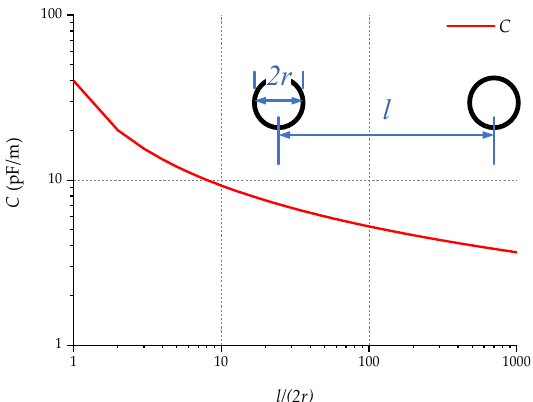
Figure 11. Relationship between the distributed capacitance of a parallel wire and its geometry ( ε = 1 ).